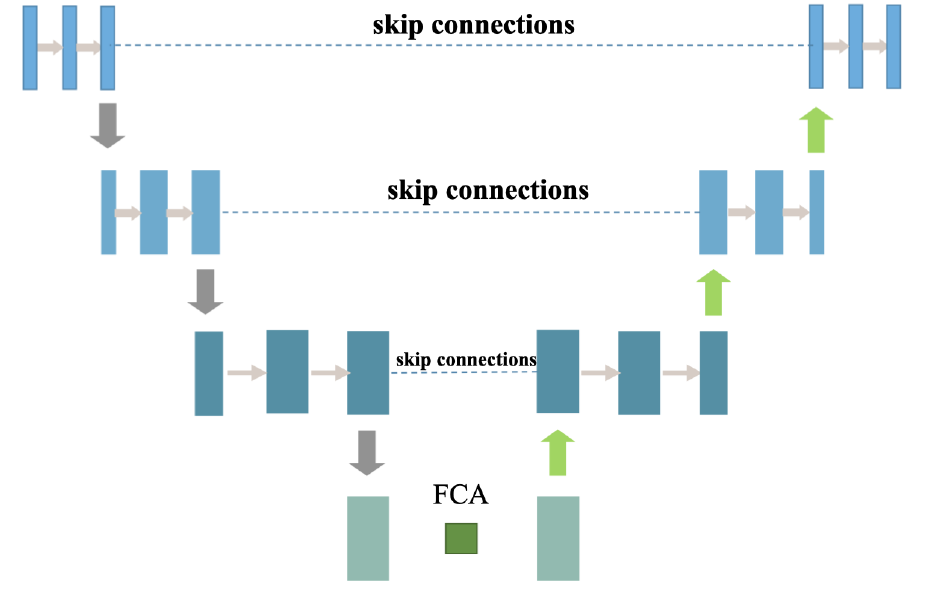
Figure 4. Diagram of the detail recovery